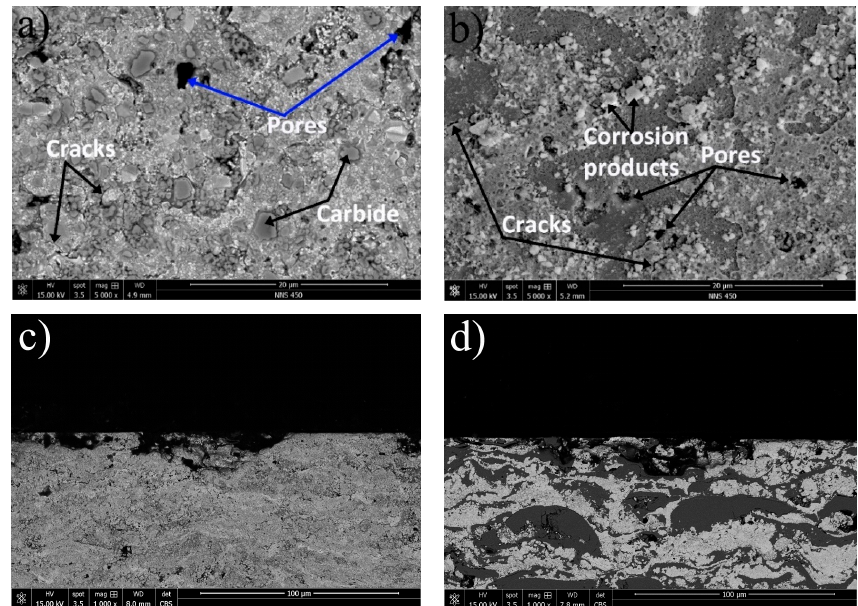
Figure 9. Surface and cross-section morphologies of ( a , c ) WC–CoCr coating and ( b , d ) composite coating after potentiodynamic polarization test in 3.5 wt % NaCl solution.